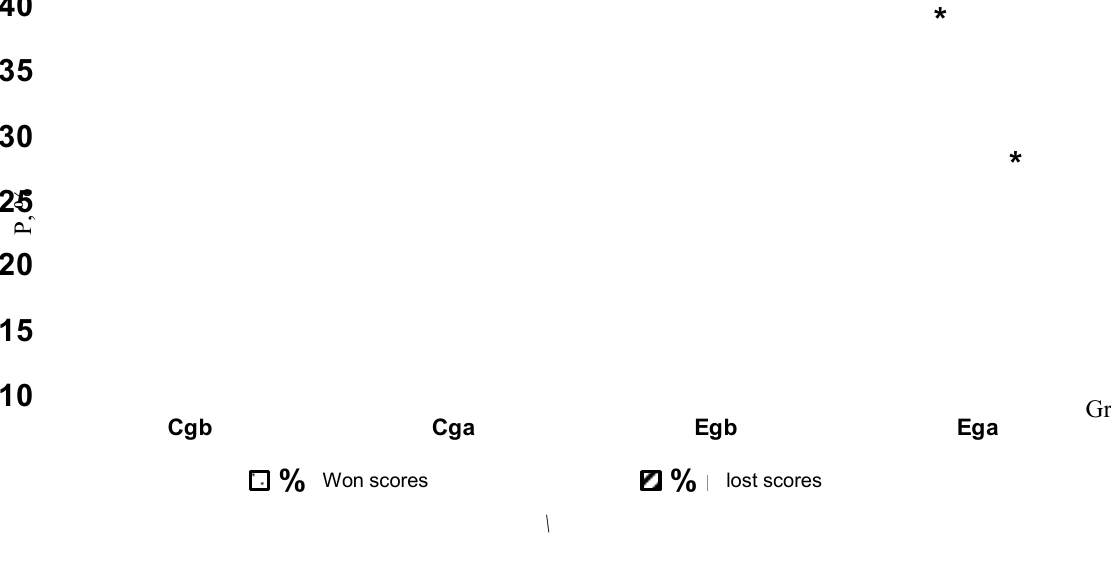
Fig.1. Percentage of won and lost scores by 14-15 years’ old tennis players at the account of own active actions before and after